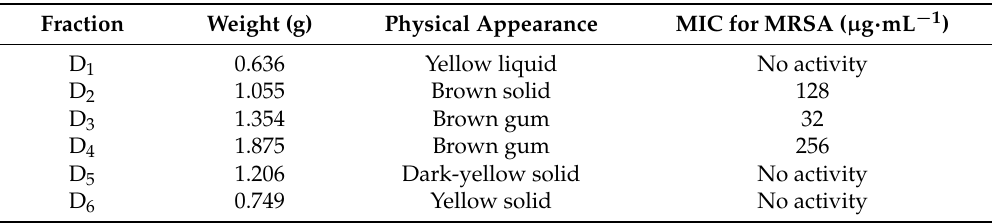
Table 1. Allium stipitatum dichloromethane (ASDE) fractions and their respective minimum inhibitory concentrations (MICs) against methicillin-resistant Staphylococcus aureus (MRSA) American Type Culture Collection (ATCC) 43300. Table 2. ASDE subfractions of D 3 and their respective MICs against MRSA ATCC 43300.